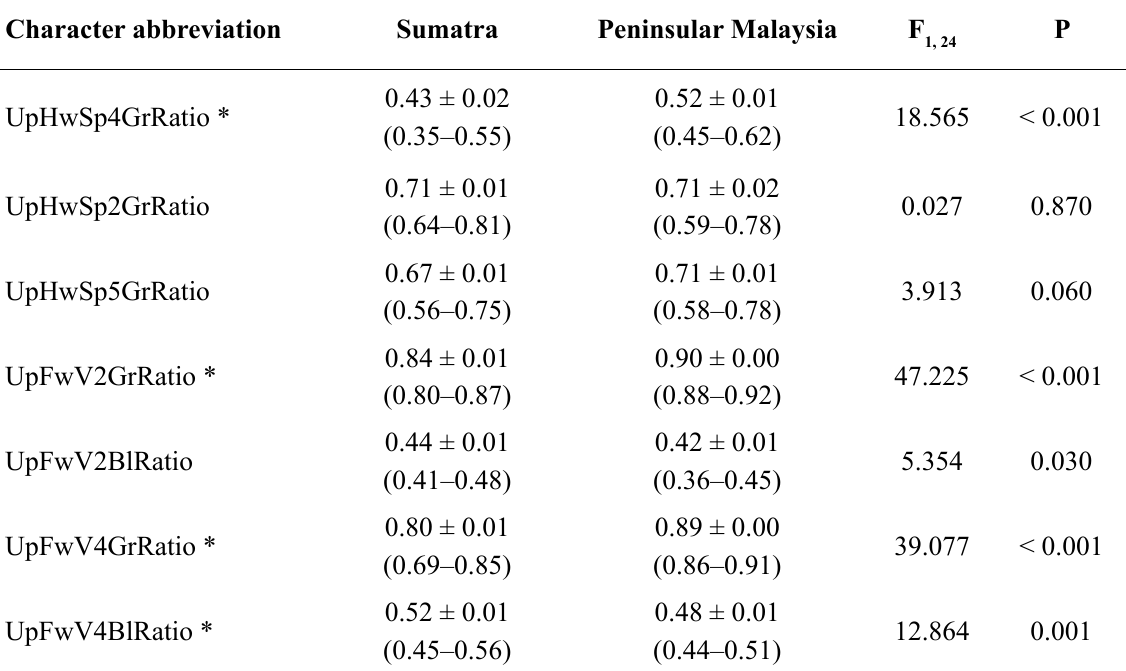
Table 2. ratio characters for Sumatran and Peninsular malaysian females (mean ± standard error, and range).